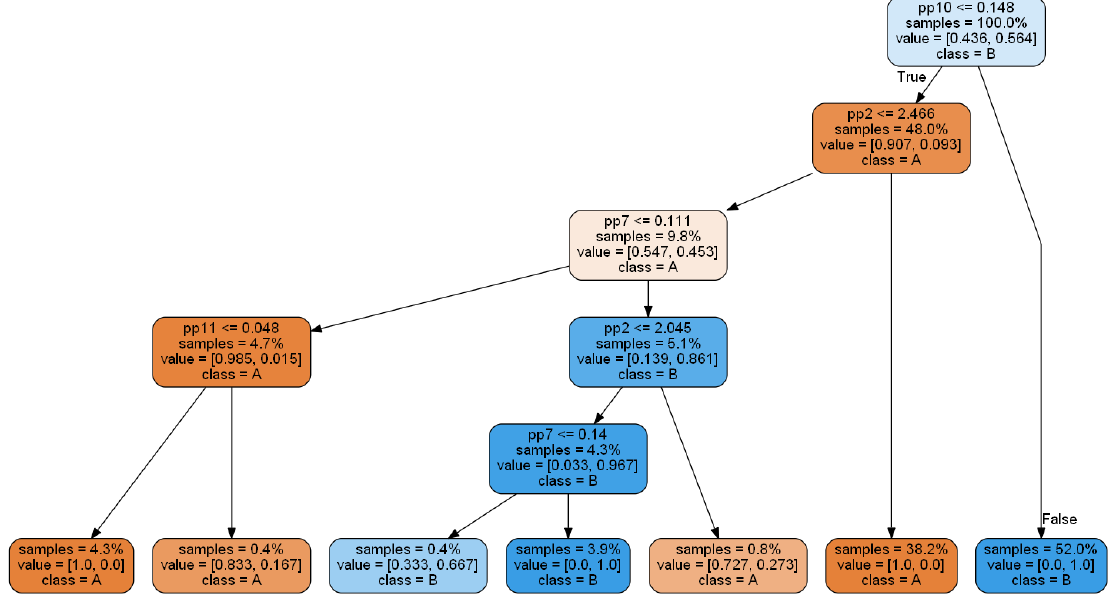
Figure 9. Generalized CART-E decision